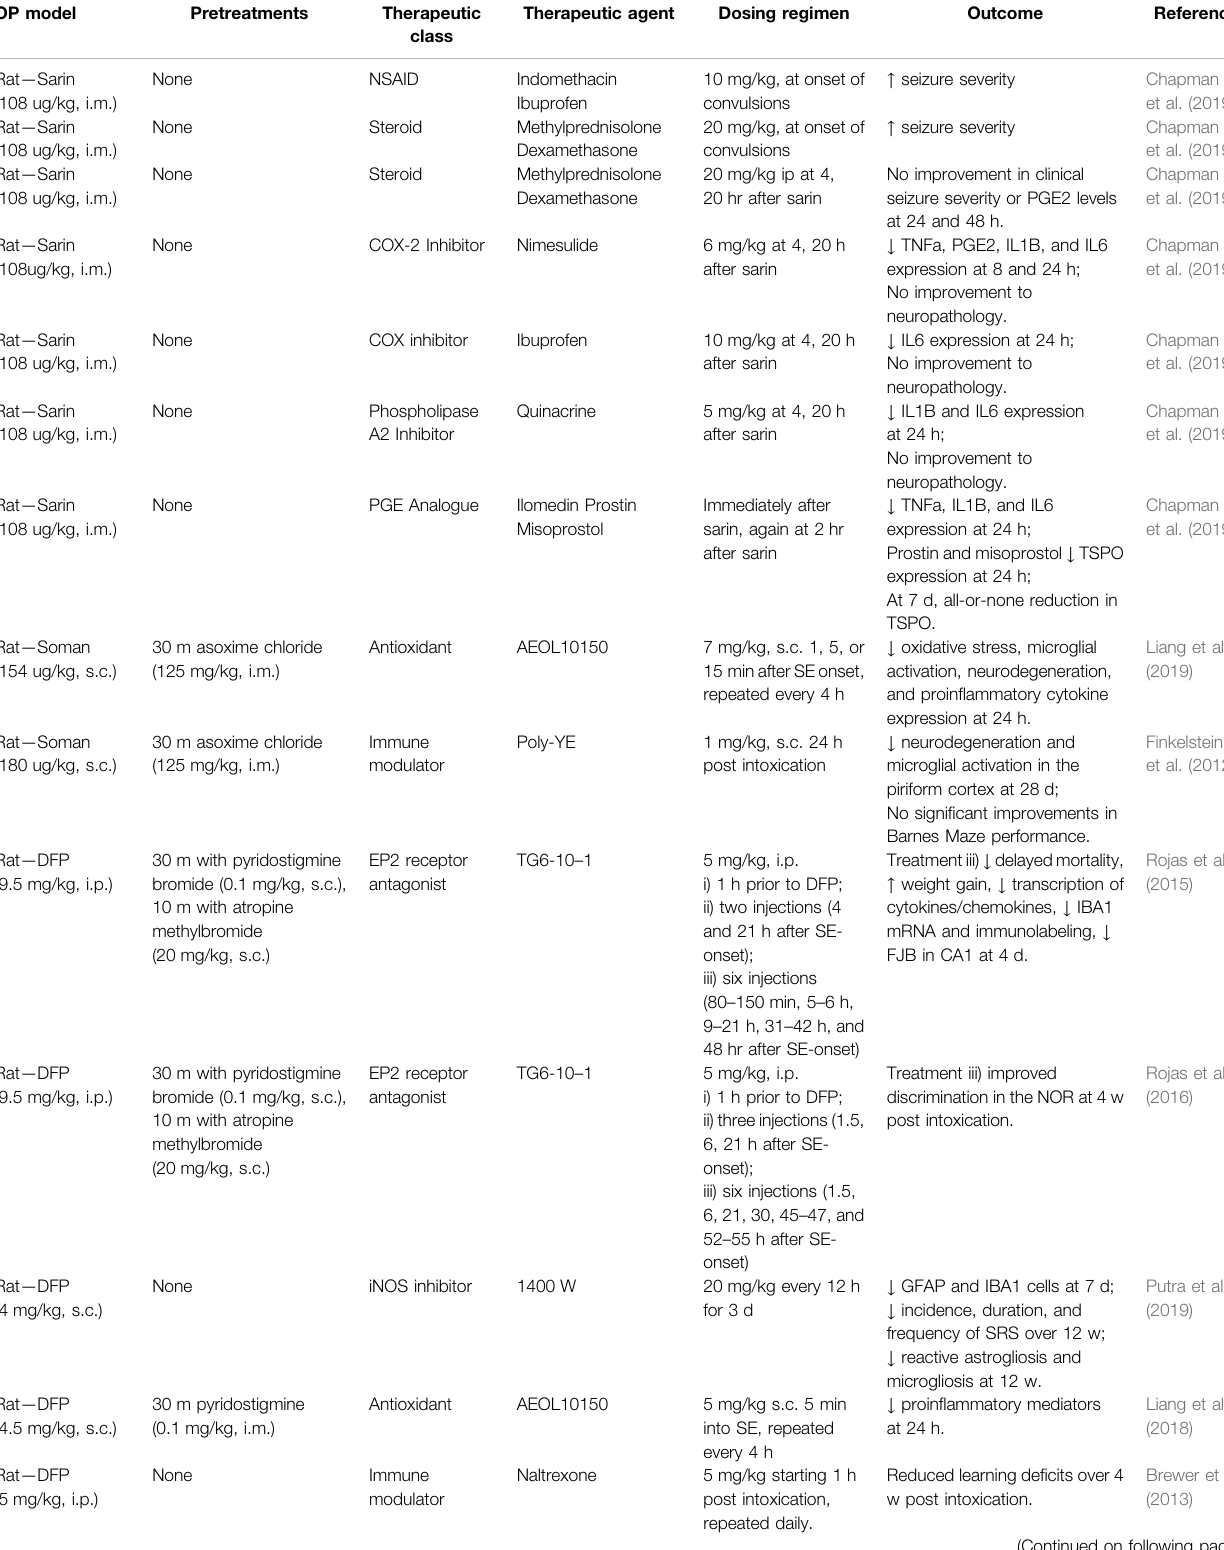
TABLE 1 | Effects of anti-in fl ammatory therapeutics in OP